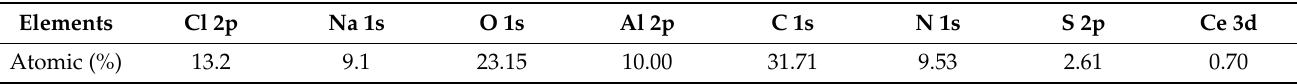
Table 4. Species present in the surface film of the test sample and their atomic